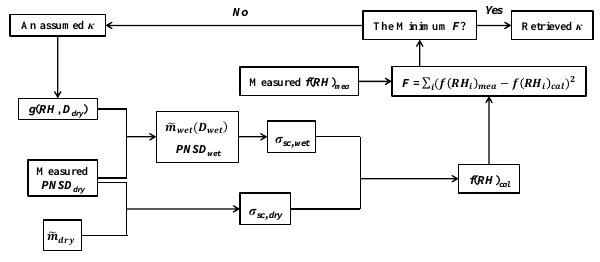
Figure 4. The flow chart of the retrieval algorithm for aerosol hy- groscopicity parameter, κ .